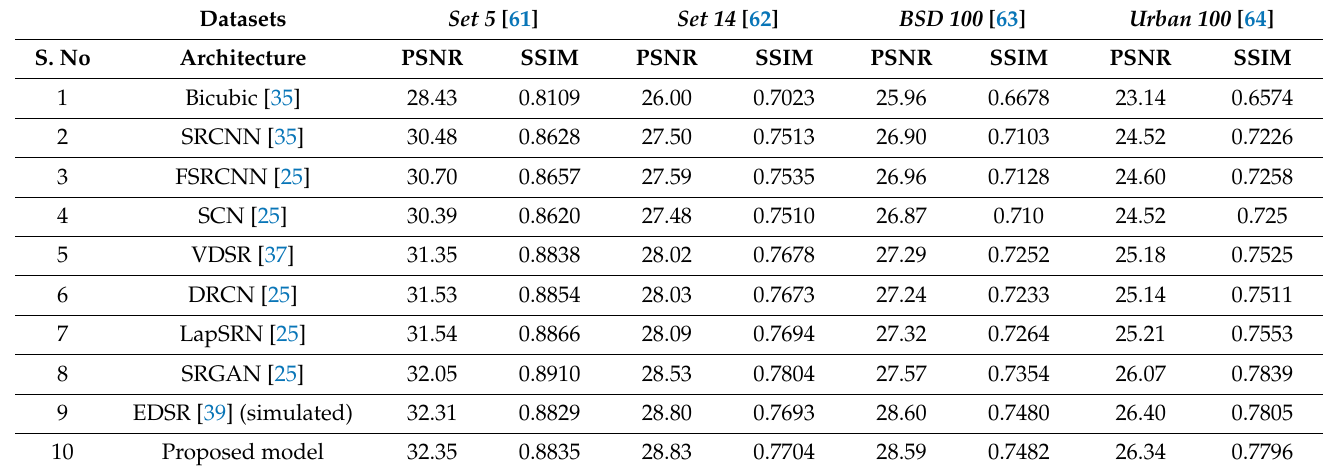
Table 2. Quantitative evaluation of the public benchmark test results of the PSNR/SSIM of Scale 4.